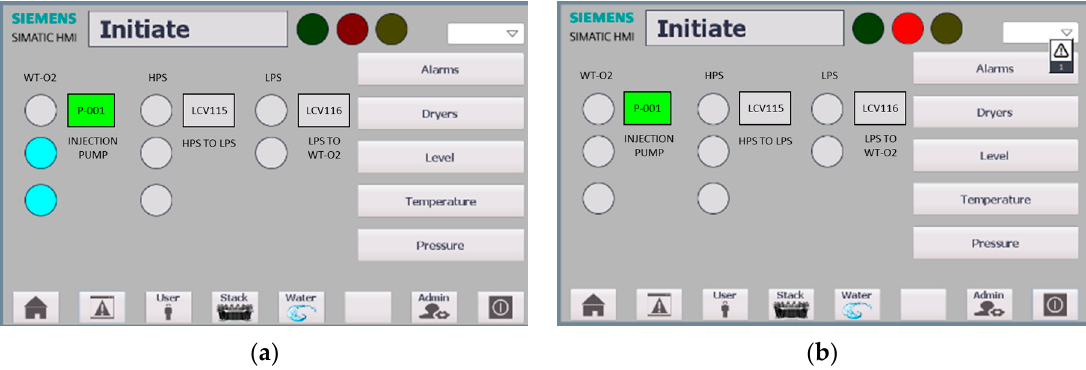
Figure 12. Water management subsystem monitoring interface: ( a ) normal operation; ( b ) low level alarm.